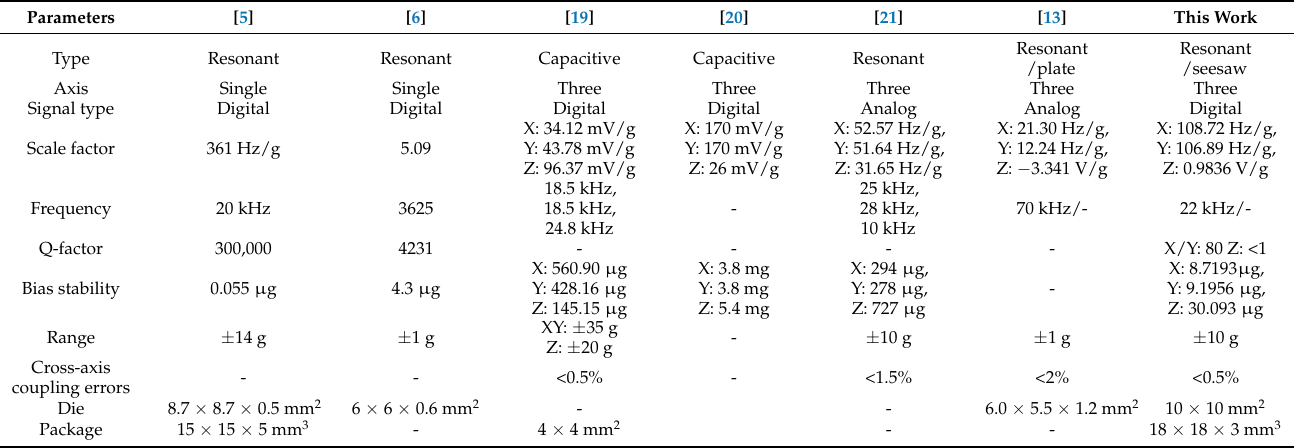
Table 8. Comparison with other resonant